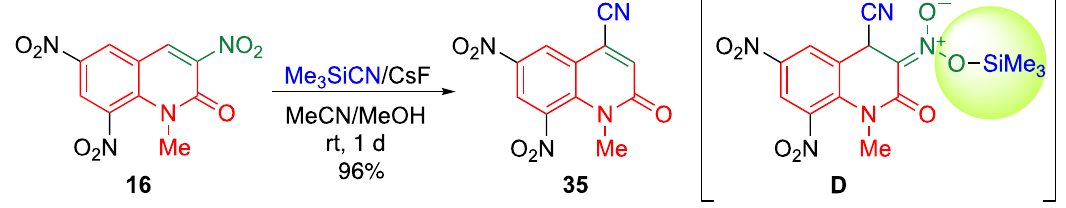
Table 11. cine -Substitution of nitrated 1,8-dimethyl-2-quinolones with trimethylsilyl cyanide.